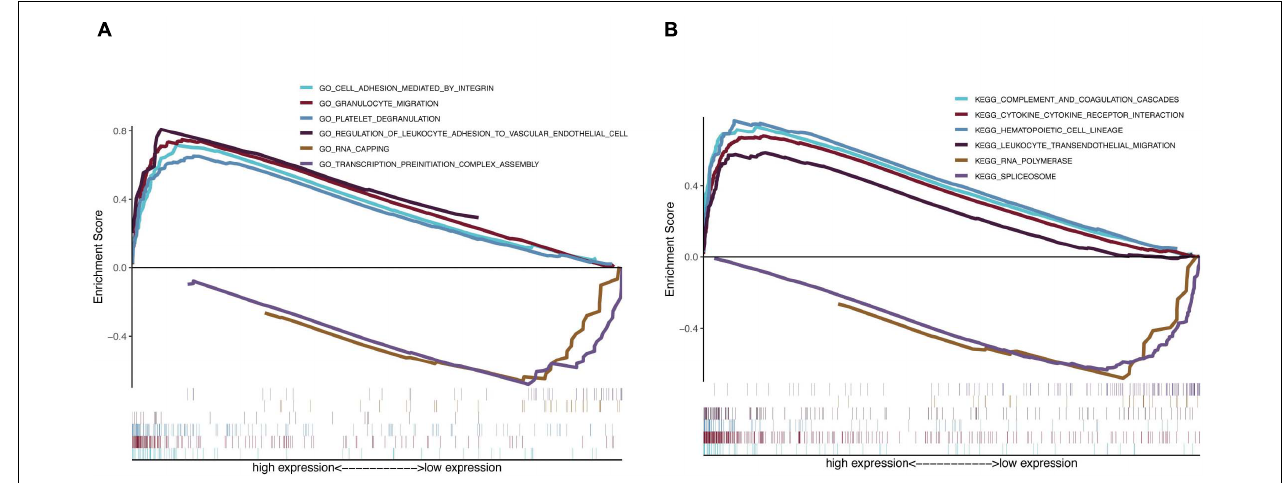
FIGURE 5 | Functional gene annotations and KEGG enrichment analysis between high and low risk groups. (A) ClusterProfiler was selected for functional gene annotations. (B) GSEA analysis was performed to identify the potential pathways differentiate the high and low risk